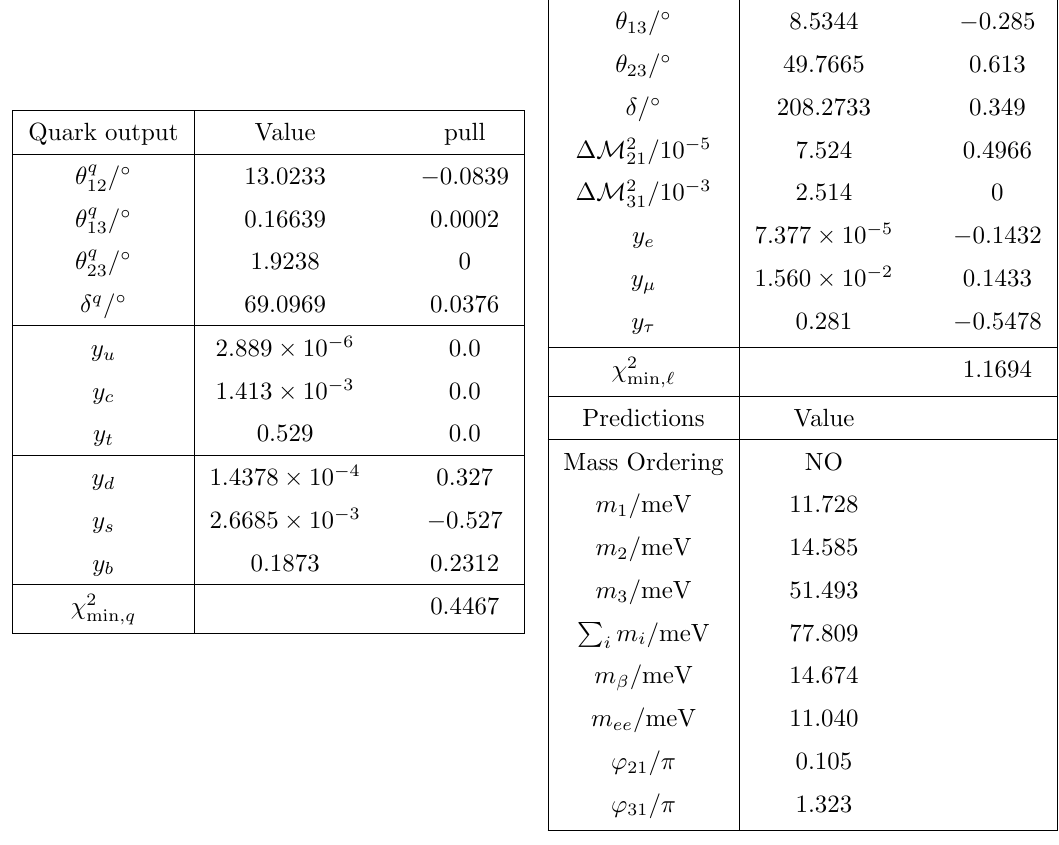
Table 6 . Left panel: the quark (cid:12)t output results. All the quark sector is (cid:12)tted to the 1 (cid:27) interval. Right panel: the output results of lepton sector. The absolute values of three light neutrino masses and the ordering as well as the two Majorana phases are pure model predictions. We have found a minimum (cid:31) 2 = 8 : 478 for inverted min ;‘